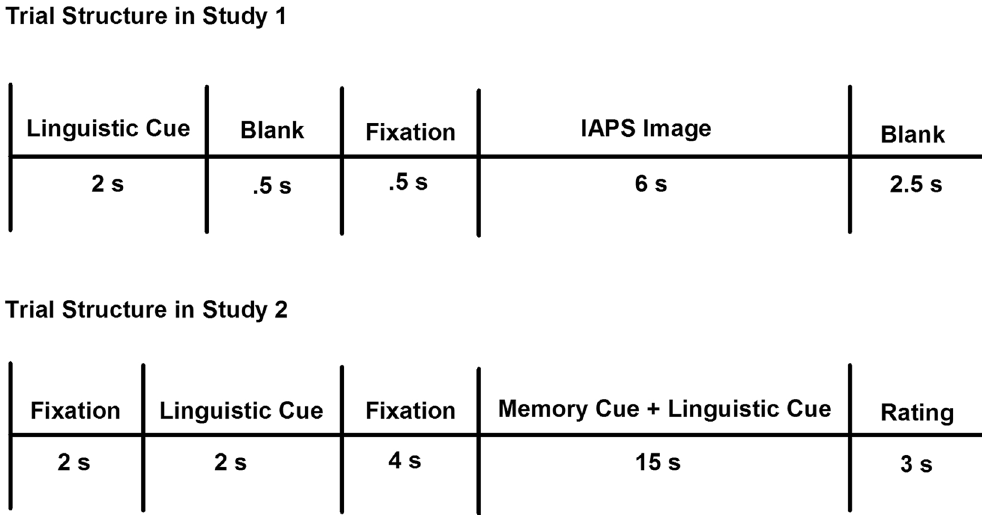
Figure 1. Visual depiction of trial structures in Study 1 (top) & Study 2 (bottom). In Study 1, participants first viewed a linguistic cue (“First-Person” or “Third-Person”) for 2 s that directed them to either use I or their own name when thinking about the following picture. Next, a blank screen was presented for 500 ms followed by a white fixation cross lasting 500 ms. Following the fixation cross, an IAPS image was displayed for 6 s. A blank screen then appeared for 2.5 s. In Study 2, each trial began with a 2 s fixation cross. Subsequently, participants saw a linguistic cue for 2 s (“I” or their own name). Next, they saw another fixation cross for 4 s. A memory cue- phrase then appeared on the center of the screen for 15 s, signaling participants to reflect on an autobiographical experience they had generated previously. The same linguistic cue that participants saw at the beginning of the trial appeared beneath the memory cue to ensure that participants continued to reflect on the memory using the appropriate part of speech. Finally, participants had 3 s to rate how they felt using a five-point scale (1 = not at all negative; 5 = very